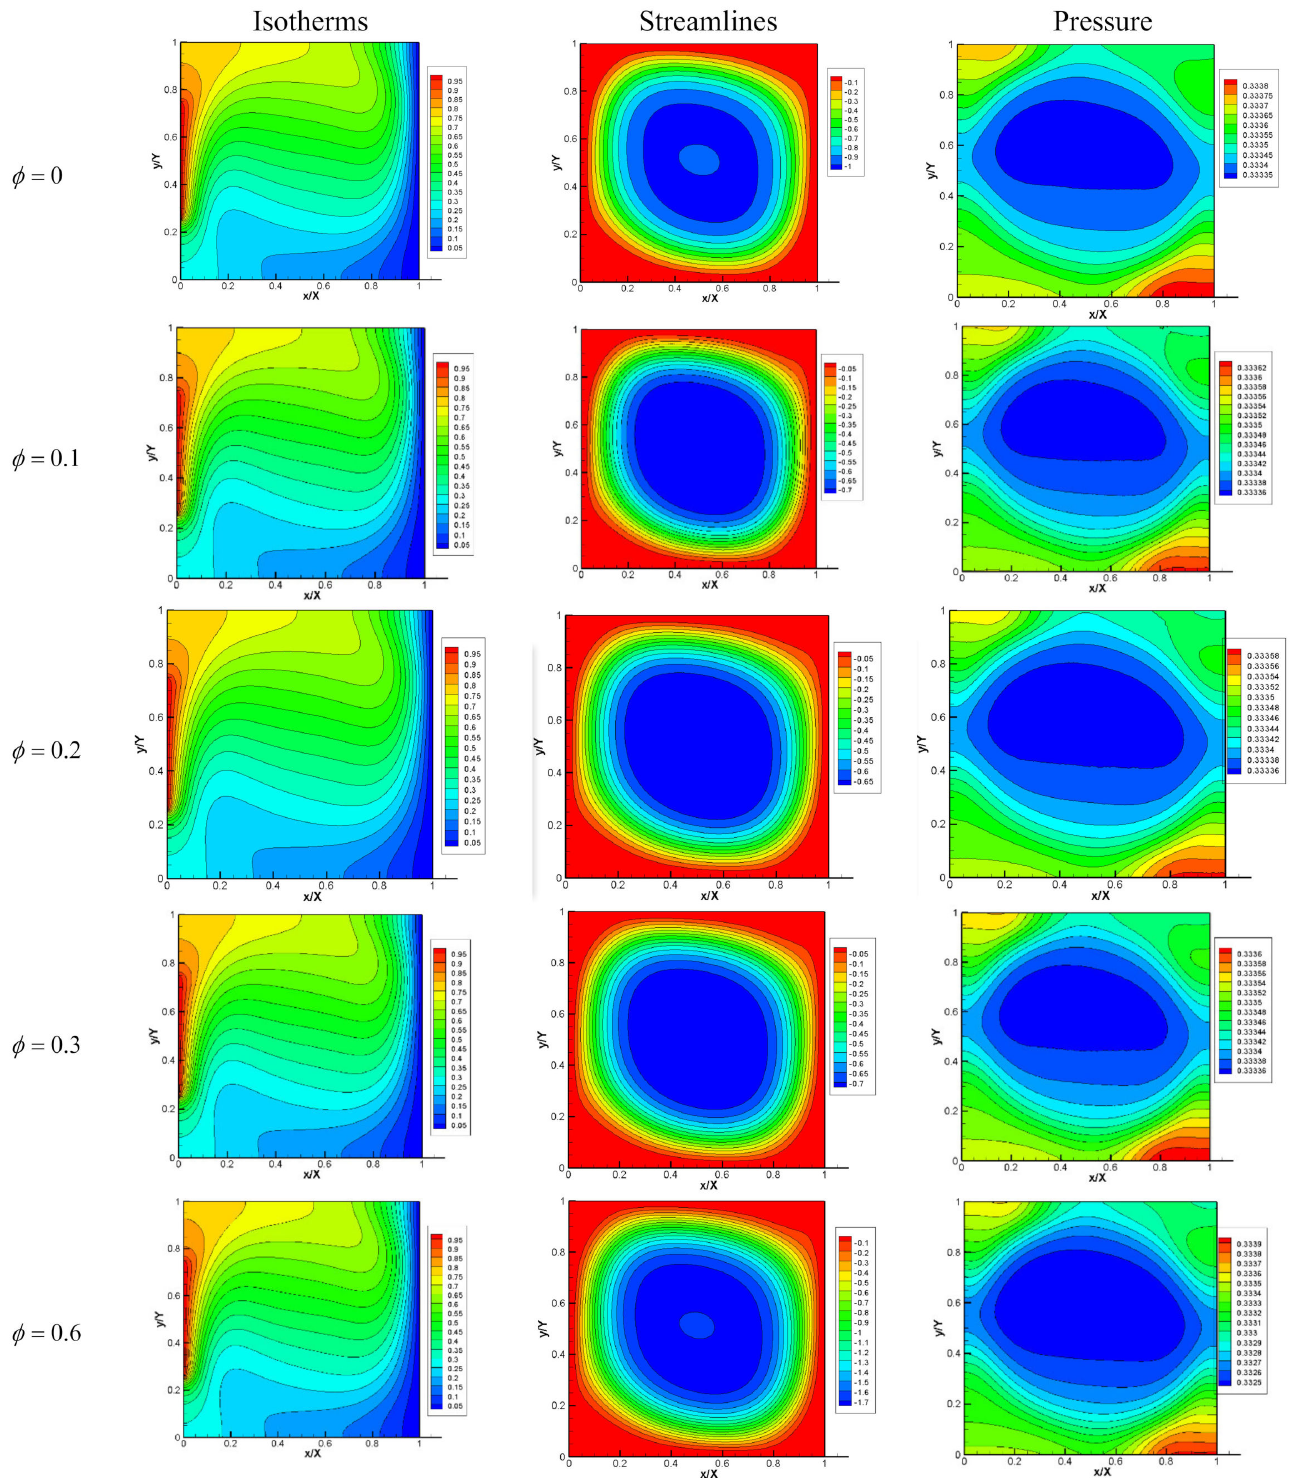
Figure 6. Steady state non-dimensional isotherm, streamline, and pressure profile behavior for central partially left boundary conditions (case 1: Dirichlet constant boundary condition) at different volume fractions ( φ ) for Ra = 10 5